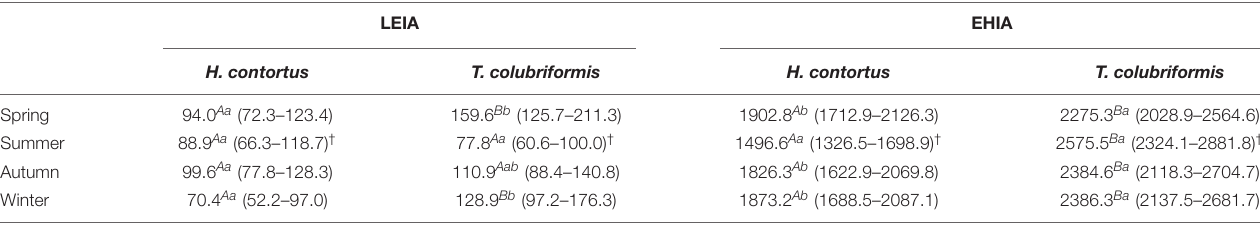
TABLE 1 | Effective concentration that inhibits 50% of larval exsheathment or egg hatching (EC 50 values, µ g mL − 1 ) and 95% confidence intervals (CI) obtained for Cladium mariscus (L.) Pohl (sawgrass) extracts on Haemonchus contortus and Trichostrongylus colubriformis L3 larvae exsheathment (LEIA) and egg hatching inhibition assays